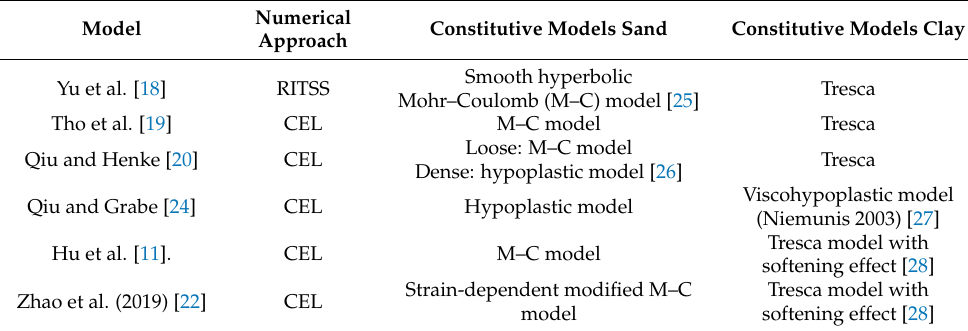
Table 1. Summary of the existing FEM models for sand overlying